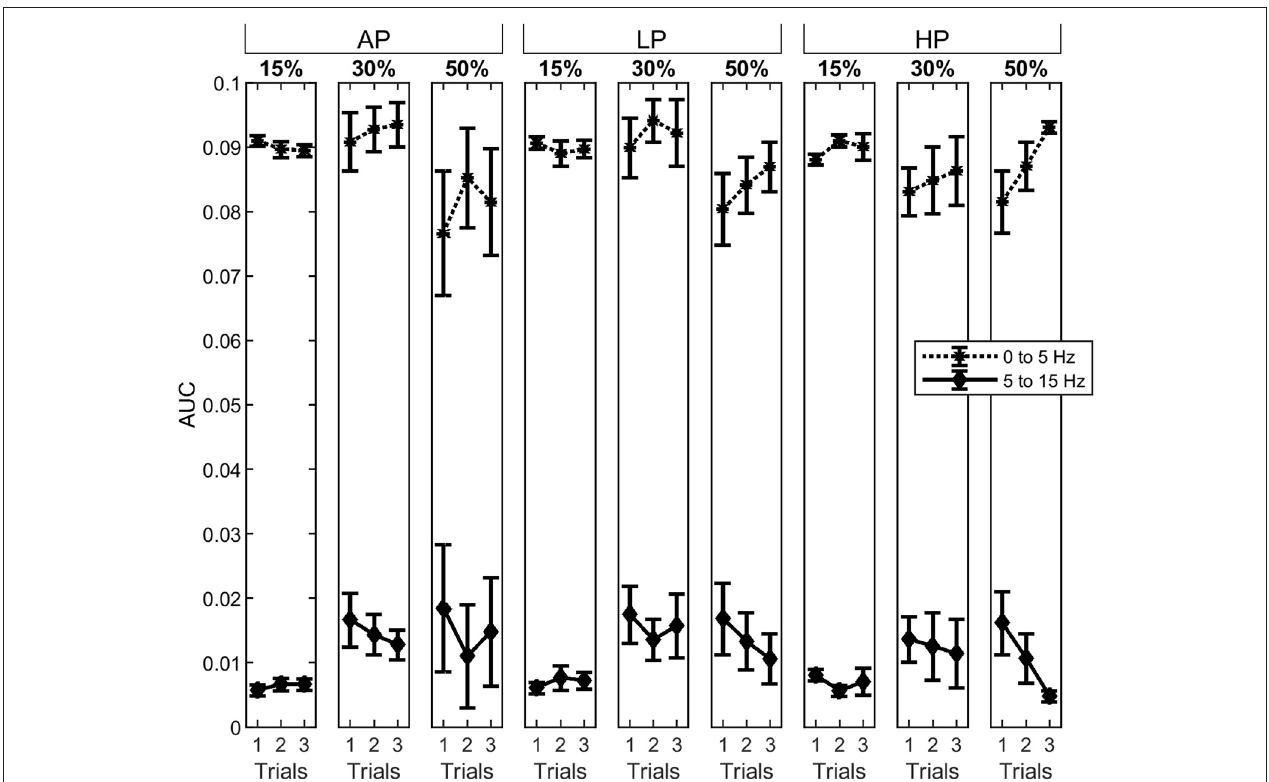
FIGURE 5 | Area under the curve (AUC) the δ - (asterisks, dotted line) and α -band (diamonds, solid line). The columns represent the different torque levels. Within each level, the AUC for all three trials was calculated as the average with standard error. The power spectrum for the AUC has been normalized, previously. Whereas, the δ -band is decreasing for increasing torque levels, the α -band is